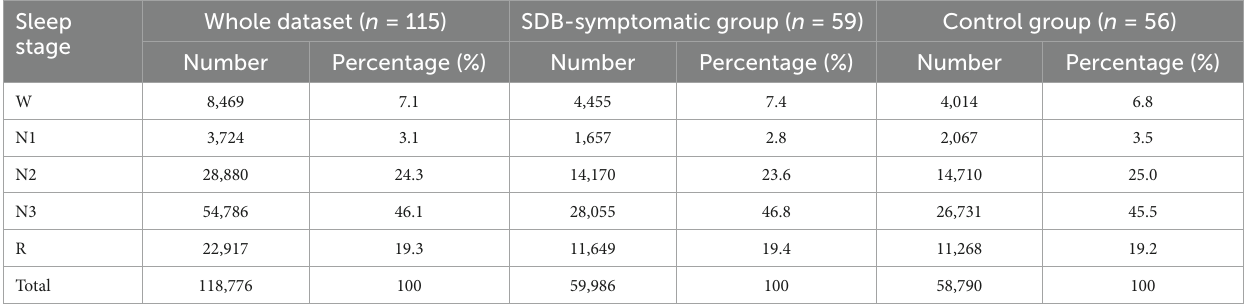
TABLE 2 Number and percentage of 30-s epochs of each sleep stage in the pediatric dataset based on initial manual reference scoring. Sleep